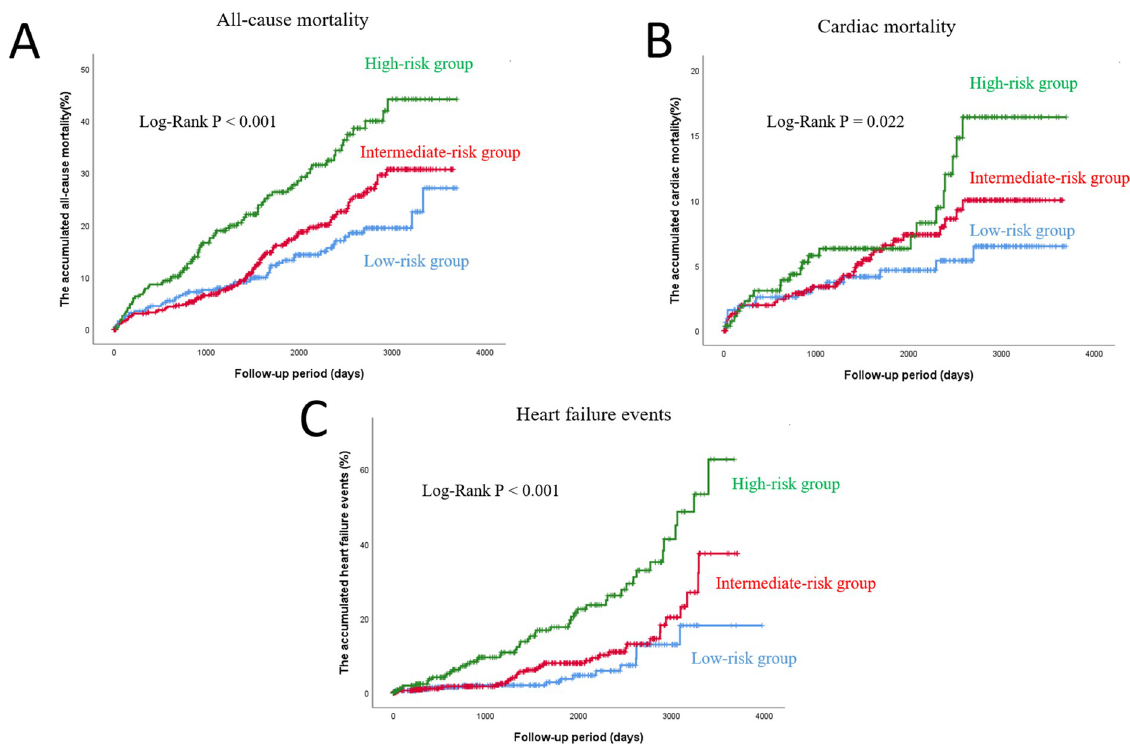
Fig 1. Kaplan-Meier curves for all-cause mortality (A), cardiac mortality (B) and hospitalization due to heart failure (C) in the high, intermediate, and low PARIS thrombotic risk score groups. PARIS, the Patterns of non-Adherence to anti-platelet Regimen in Stented